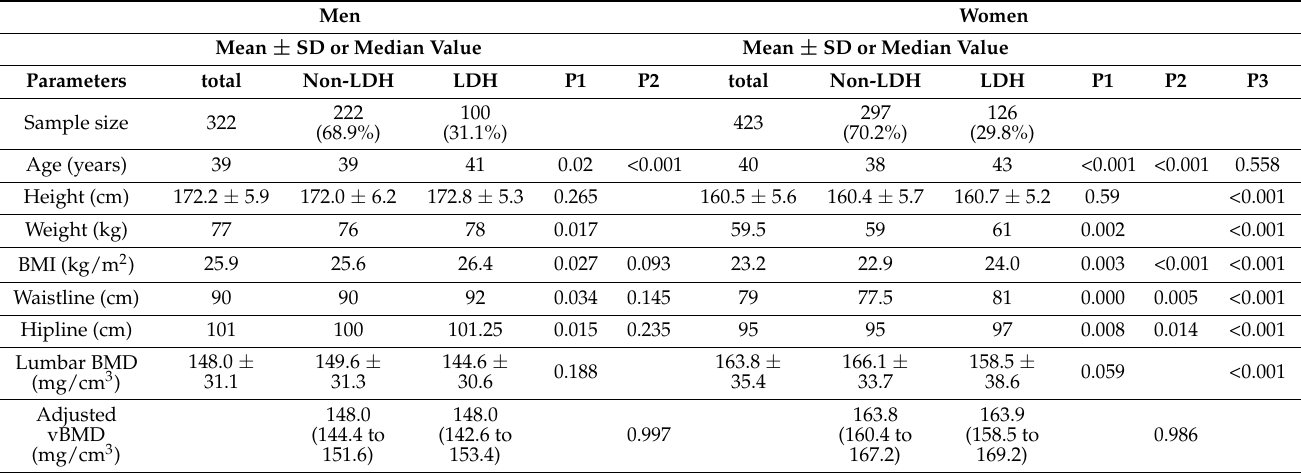
Table 1. Characteristics of the study group.